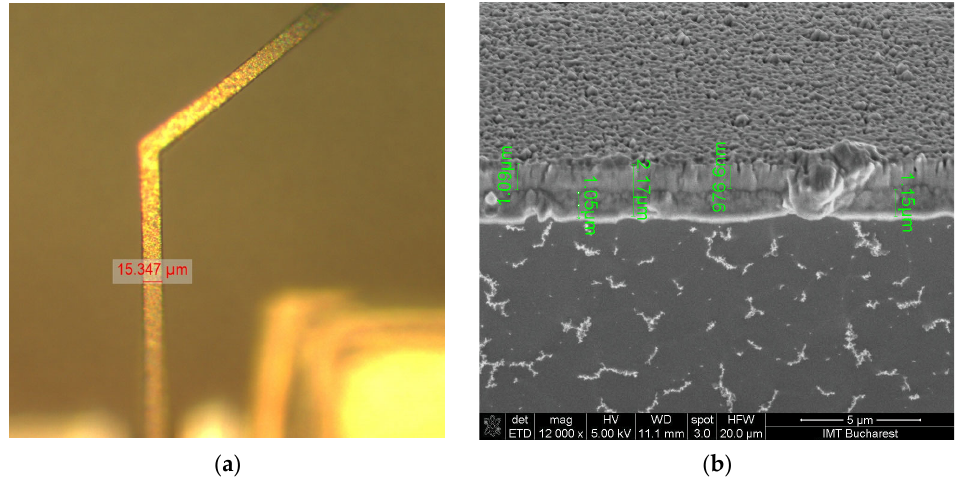
Figure 4. Measured dimensions of the fabricated micro-tweezer: ( a ) Optical measurement of the arms’ width after release; ( b ) SEM image of thickness measurements.